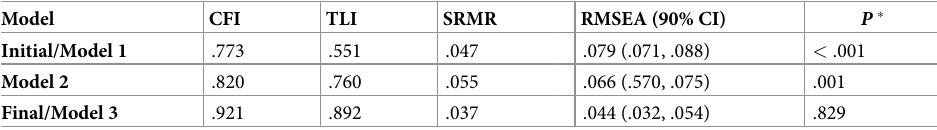
Table 2. Summary of goodness-of-fit indices: Hypothesised structural